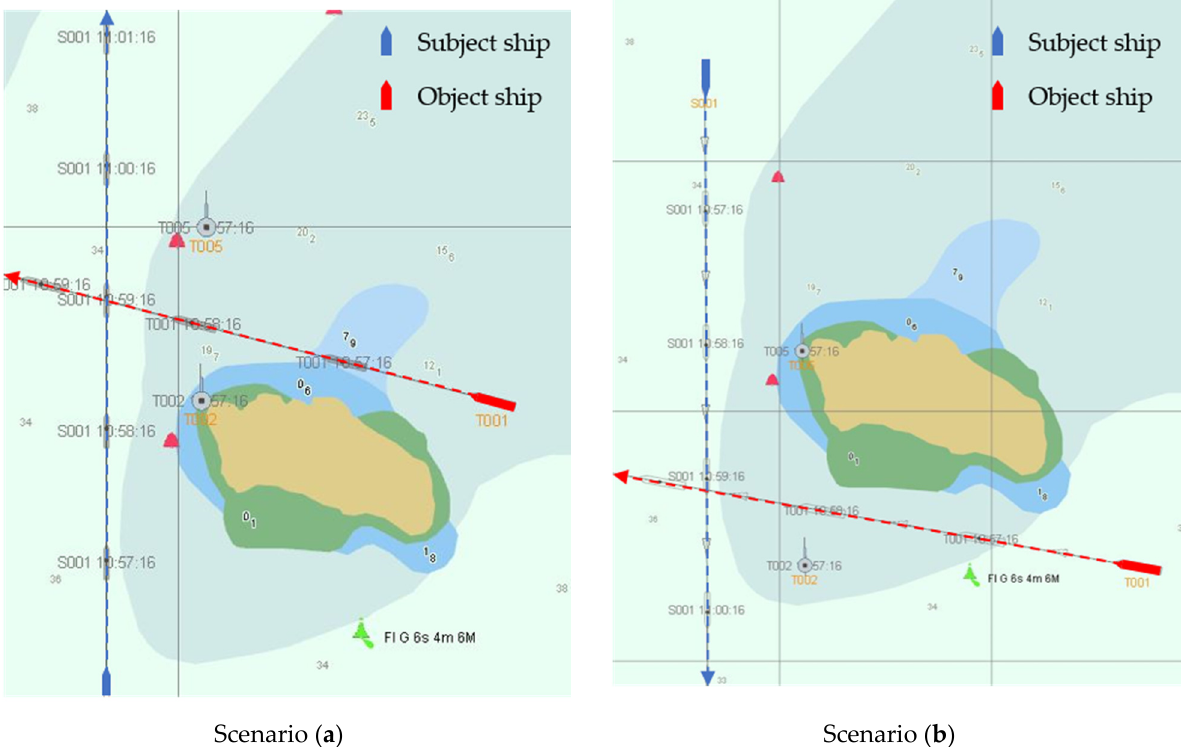
Figure 3. Experiment scenario of different alarm delivery methods.